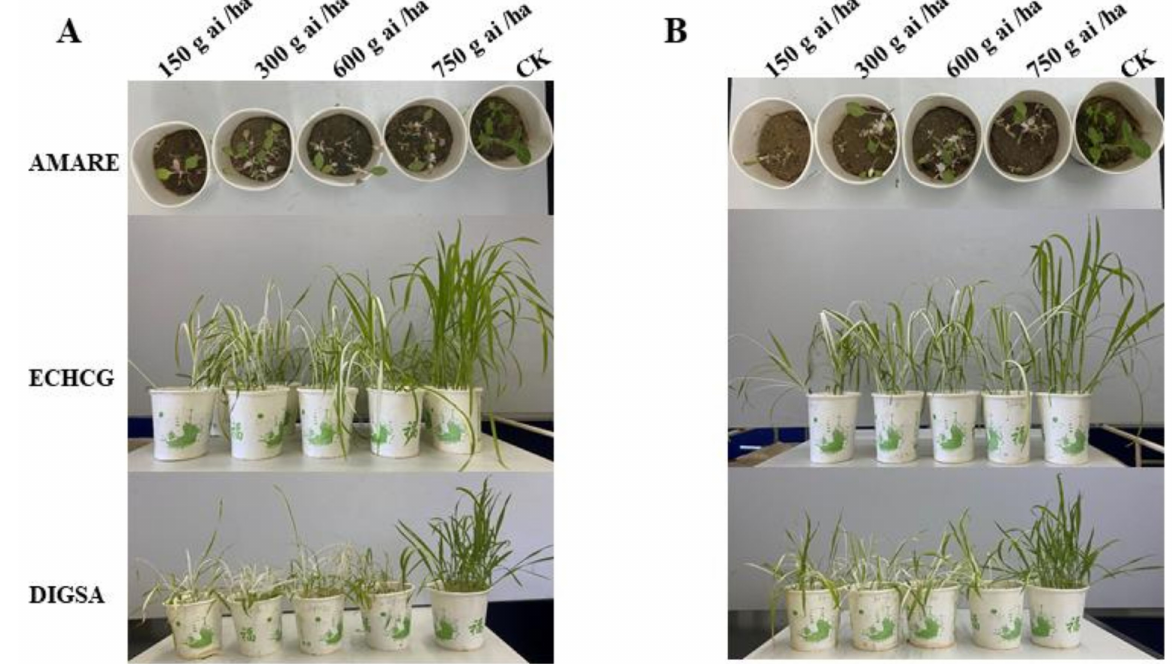
Figure 3. The injury symptoms of Eclipta prostrata (ECLPR), Amaranthus retroflexus (AMARE), and Digitaria sanguinalis (DIGSA) after treatment with 3h ( A ) and diflufenican ( B ) at a dosage range from 150 to 750 g ai/ha by a post-emergence application, the photos were taken at 20th day after